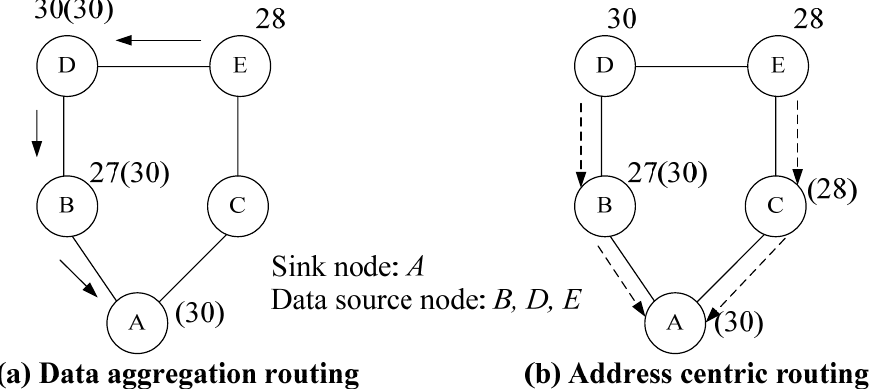
Figure 2. Data aggregation in data aggregation routing and address centric